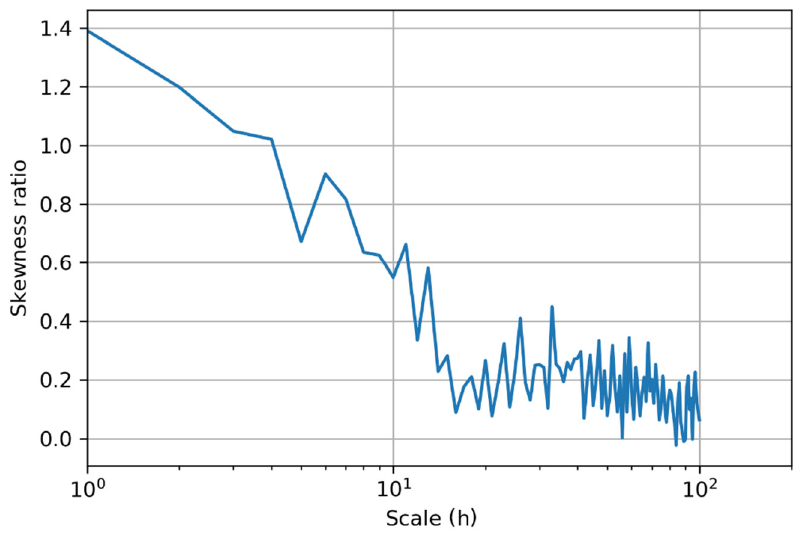
Figure 3. Scale-wise irreversibility index of the streamflow of the Monocacy River.